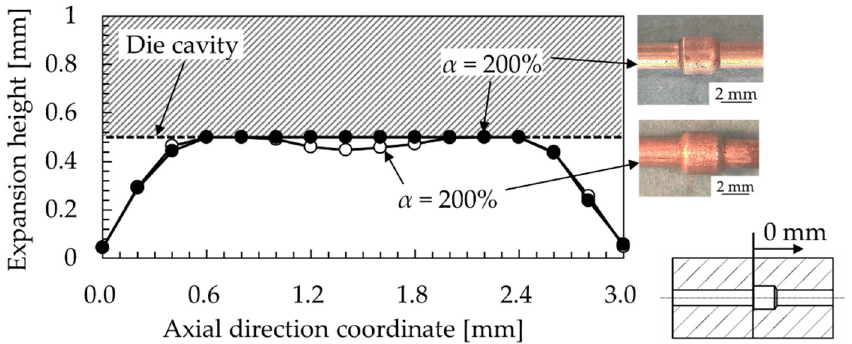
Figure 26. Expansion distribution of the deformed tube, which was loaded with a higher internal pressure for the straightening of the wrinkle in the cylinder-shape warm THF at 250 °C.